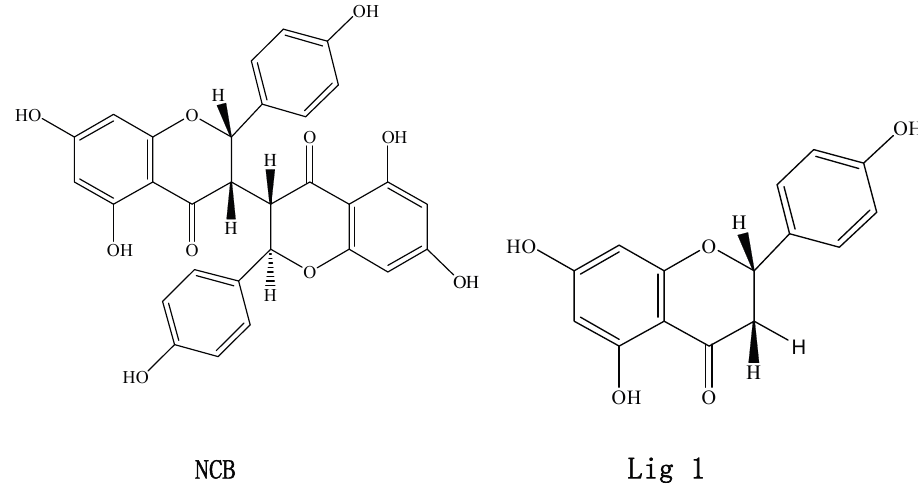
Figure 1. Chemical structures of neochamaejasmin B (NCB) and Lig 1 (( S )-5,7-dihydroxy- 2-(4-hydroxyphenyl)chroman-4-one). Neochamaejasmin B was isolated and purified